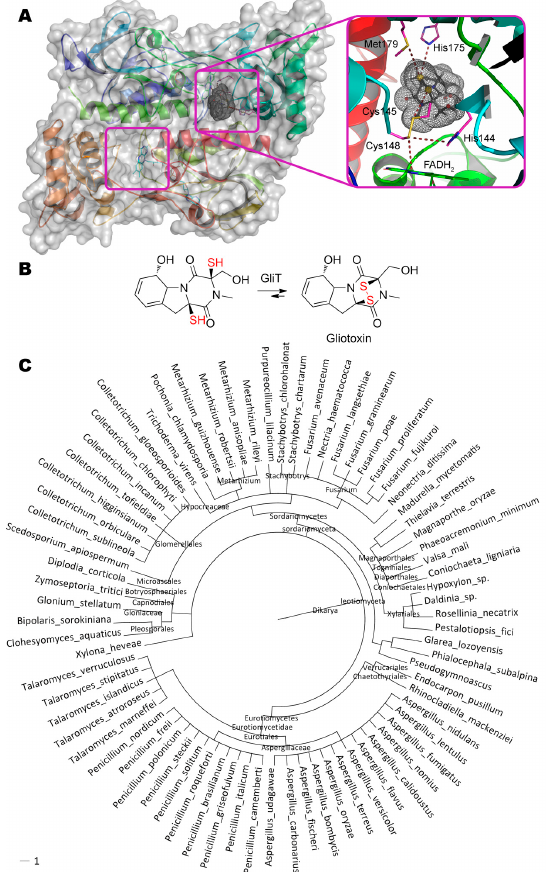
Figure 4. ( A ) Structure of gliotoxin oxidoreductase GliT (PDB 4ntc) containing gliotoxin in its active center, and ( B ) scheme of substrate conversion with GliT. Position and geometry of substrate binding was determined as described early. ( C ) Phylogenetic tree of microorganisms possessing homologous enzymes found with BLAST.